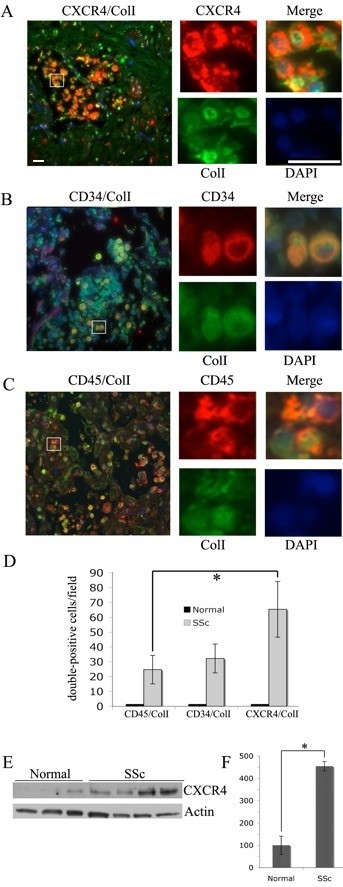
Fibrocyte subsets in lung tissue of patients with systemic sclerosis-interstitial lung disease. Fixed, paraffin-embedded lung tissue sections from normal adults and adults with systemic sclerosis-interstitial lung disease (SSc-ILD) were stained for CD34, CD45, C-X-C chemokine receptor type 4 (CXCR4) and collagen I (ColI). Nuclei were stained with 4',6-diamidino-2-phenylindole (DAPI) (blue). Left: low-magnification images. Right: high-magnification images. The portion of the low-magnification image that is presented at high magnification is boxed. (A) CXCR4 (red)/ColI (green). (B) CD45 (red)/ColI (green). (C) CD34 (red)/ColI (green). (D) The number of double-labeled cells per field was determined from images of sections obtained from seven SSc-ILD patients and four normal subjects, with six randomly chosen fields per sectio. *P < 0.05. CXCR4 expression was evaluated by performing Western blot analysis on extracts of three normal lung samples and four SSc-ILD lung samples (E) and then quantifying them densitometrically (F) using actin as a loading control. Bars = 10 μm.